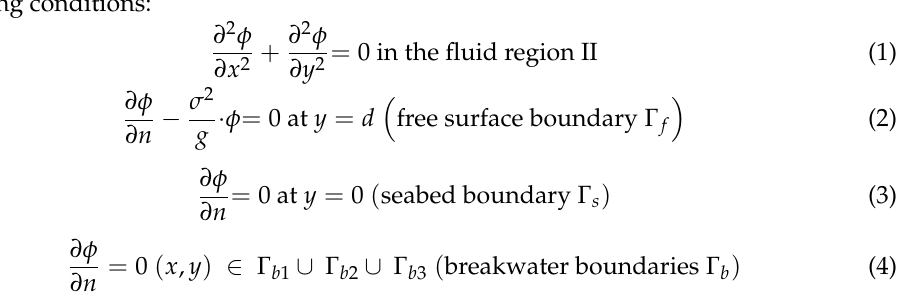
Figure 2. Problem definitions for the breakwater system.